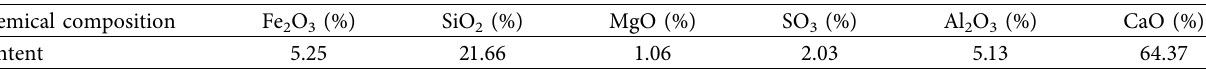
Table 2: Cement chemical composition (mass fraction).